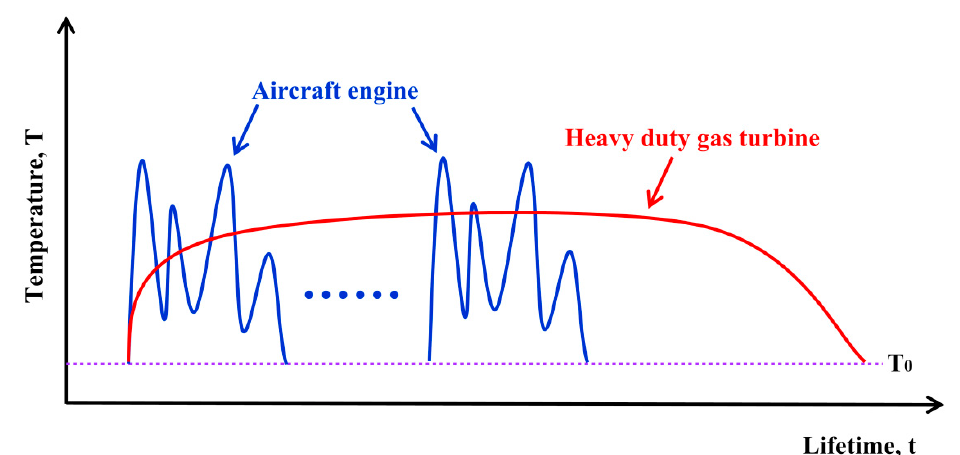
Figure 1. Schematic diagram of the typical service conditions of aero-engines and heavy-duty gas turbines. T 0 is the initial temperature.